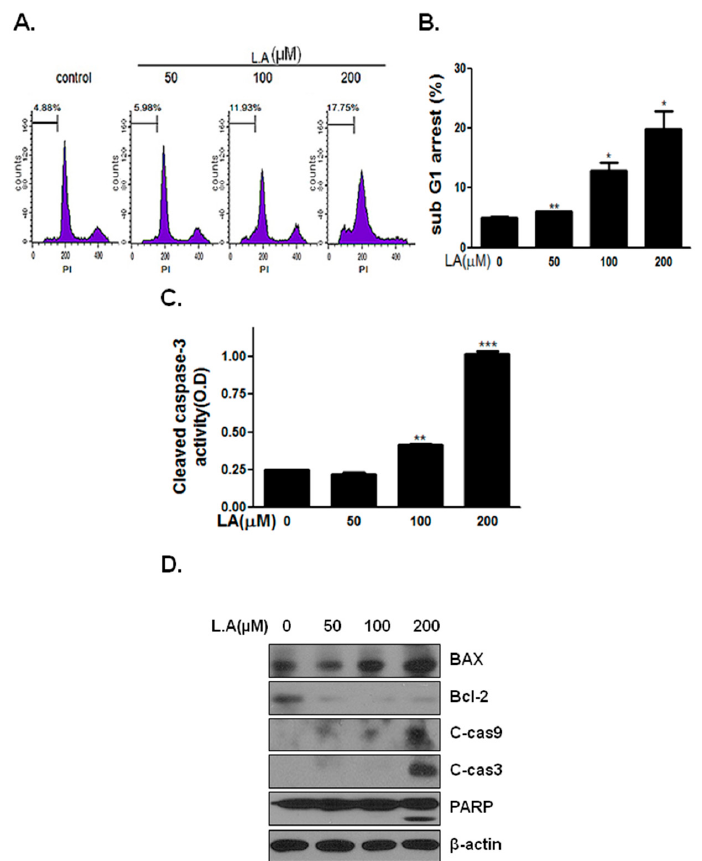
Figure 2. Effect of LA on induced apoptosis after 48 h of incubation with LNCaP cells. ( A ) LNCaP cells were treated with LA (0, 50, 100 and 200 µ M) for 48 h and then stained with propidium iodide (PI) after fixation. Stained cells were analyzed using a FACS Vantage flow cytometry system. Analysis